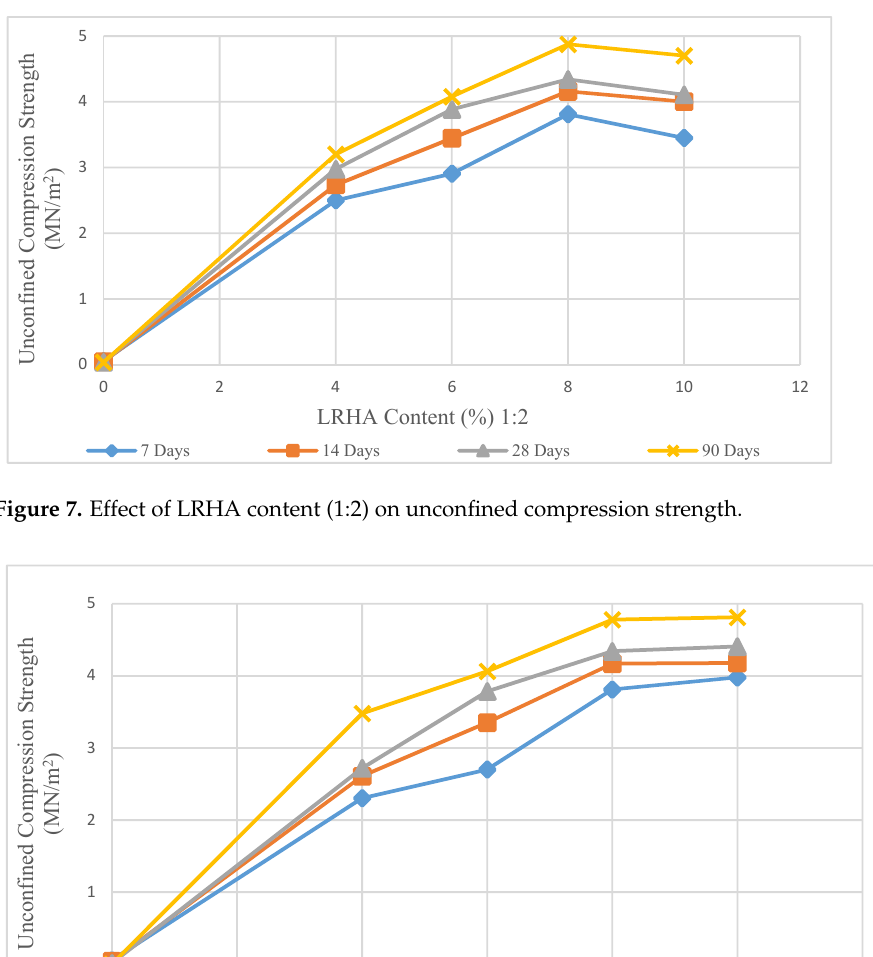
Figure 8. Effect of CRHA (1:2) content on unconfined compression strength. 3.3. Shear Stress Behavior Figure 9 shows the changes in shear stress ( τ ) versus horizontal strain on pure soil and specimens treated with 4 and 8% LRHA and CRHA at the ratio of 1:2, under normal stress of 0.5 MPa for curing periods of 7 days and 14 days.